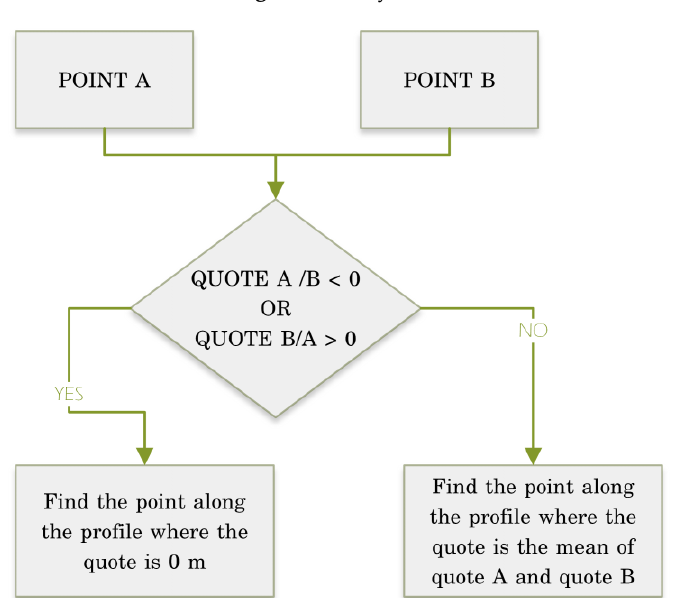
Figure 1. Study area.